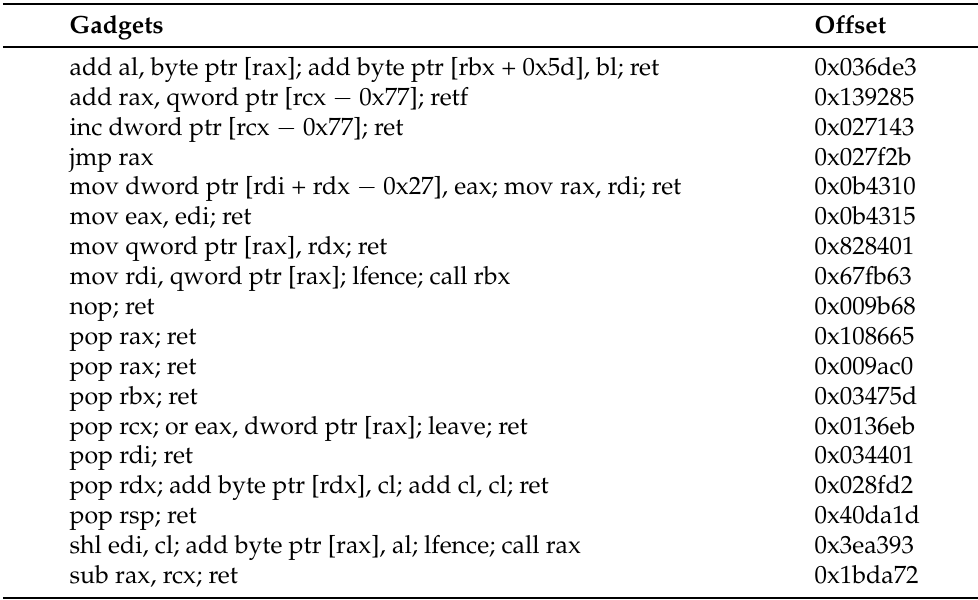
Table A2. Gadget list in Mystikos.